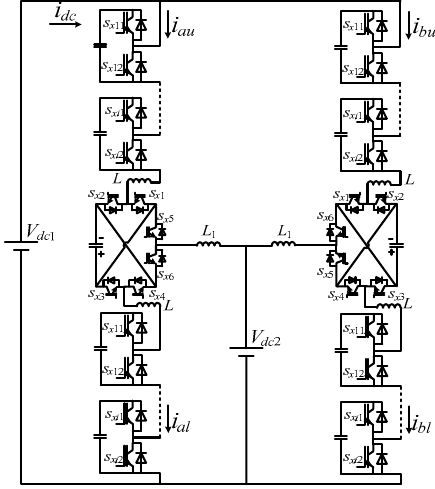
Figure 1. Basic structure of the proposed DC-DC MMC.